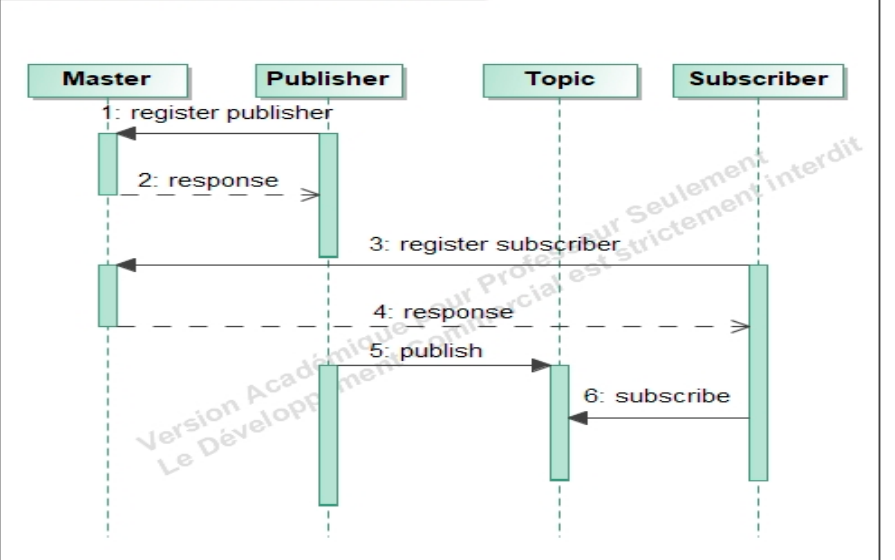
Figure 1. Robot Operating System (ROS) system process.